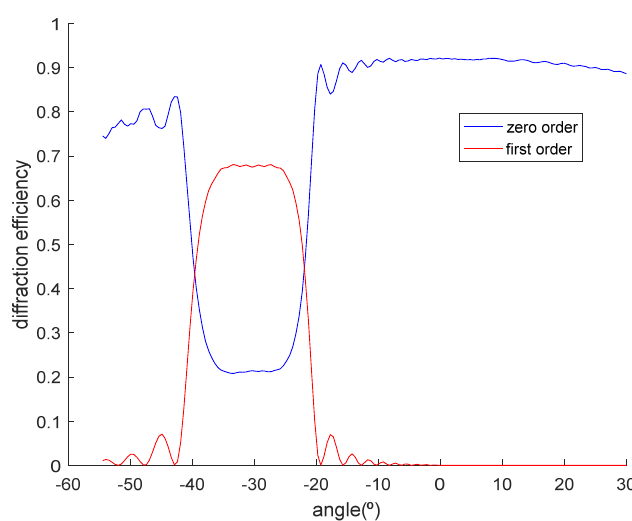
Figure 6. Diffraction and transmission efficiency as a function of the angle for a noise reflection grating Figure 6. Di ff raction and transmission e ffi ciency as a function of the angle for a noise reflection grating after swelling. after swelling.